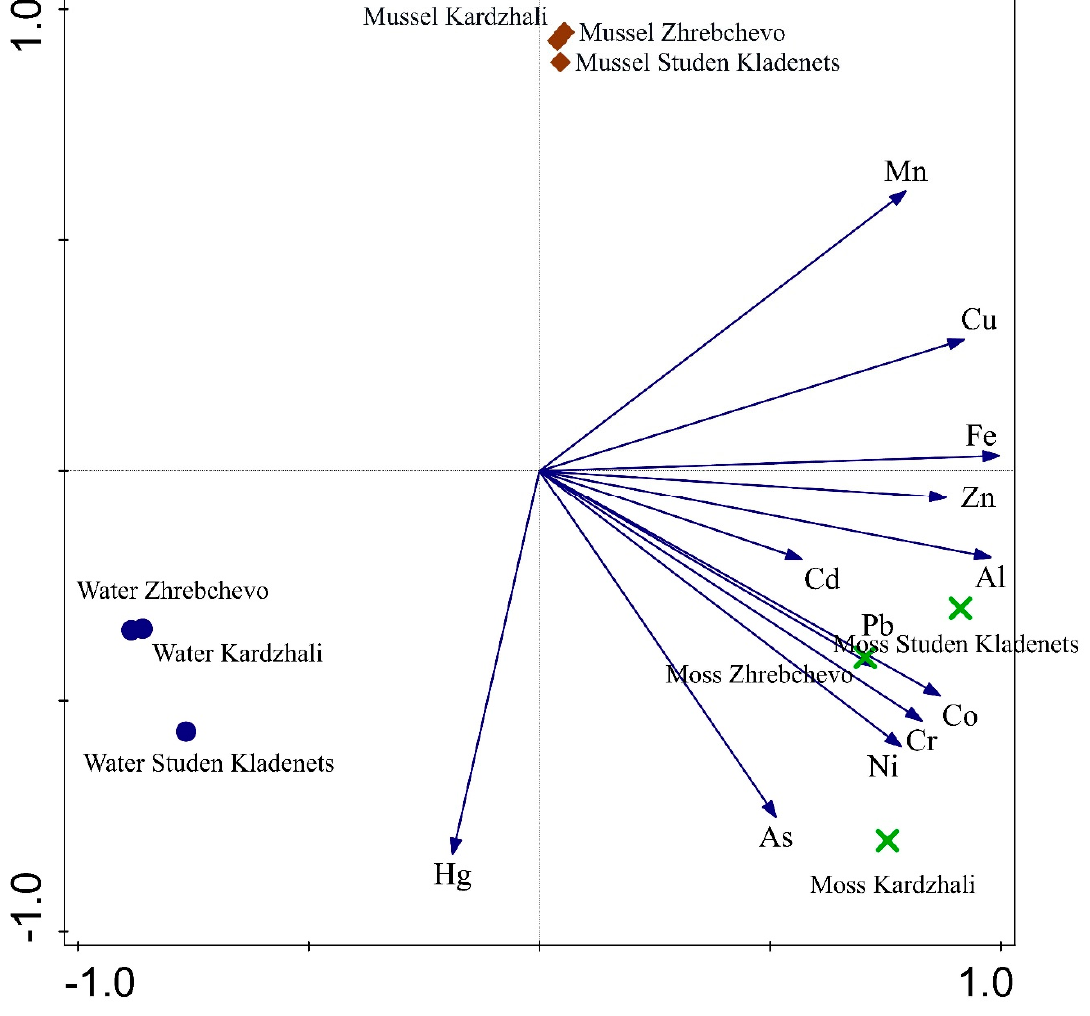
Figure 4. Principal component analysis (PCA) scatterplot of the three studied matrices: water, moss, and mussel samples.